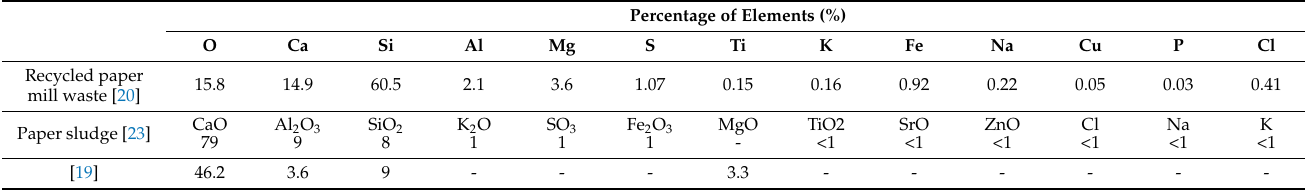
Table 3. Elemental analysis of paper waste sludge [19,20,23]. Percentage of Elements